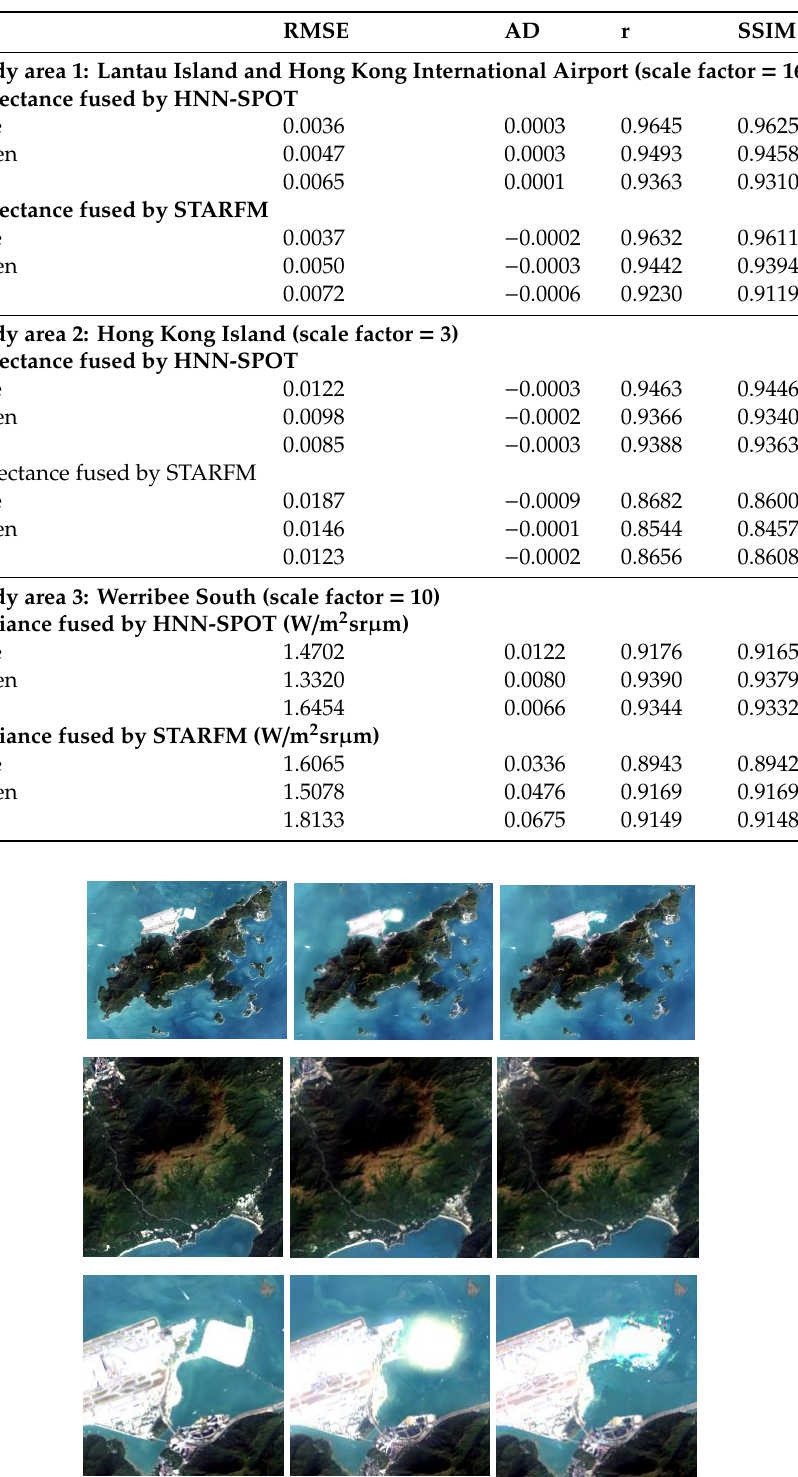
Table 3. Quantitative assessments on HNN-SPOT and STARFM (for study area 1-3).